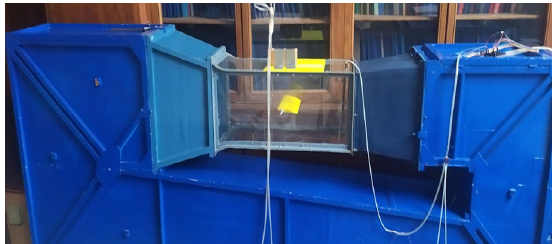
Figure 1. Wind tunnel, experimental set-up For different inlet velocities (ranging from 5 m/s to 25 m/s with 2.5 m/s steps) static pressure at the wind tunnel outlet working area was measured using DSP